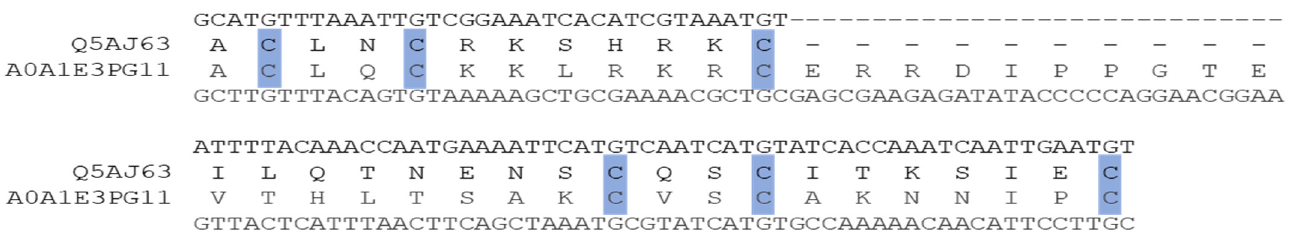
Figure 7. Predicted DBD for Candida albicans sequence Q5AJ63_CANAL, aligned with neighbor sequence A0A1E3PG11_9ASCO (hmmsearch E-value = 6.5 × 10 − 10 ). Conserved cysteines characterizing the Zn2C6 DBD are highlighted in blue.